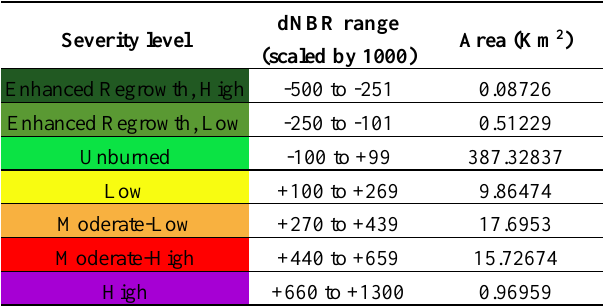
Table 2: Fire severity classes and the burned area per class